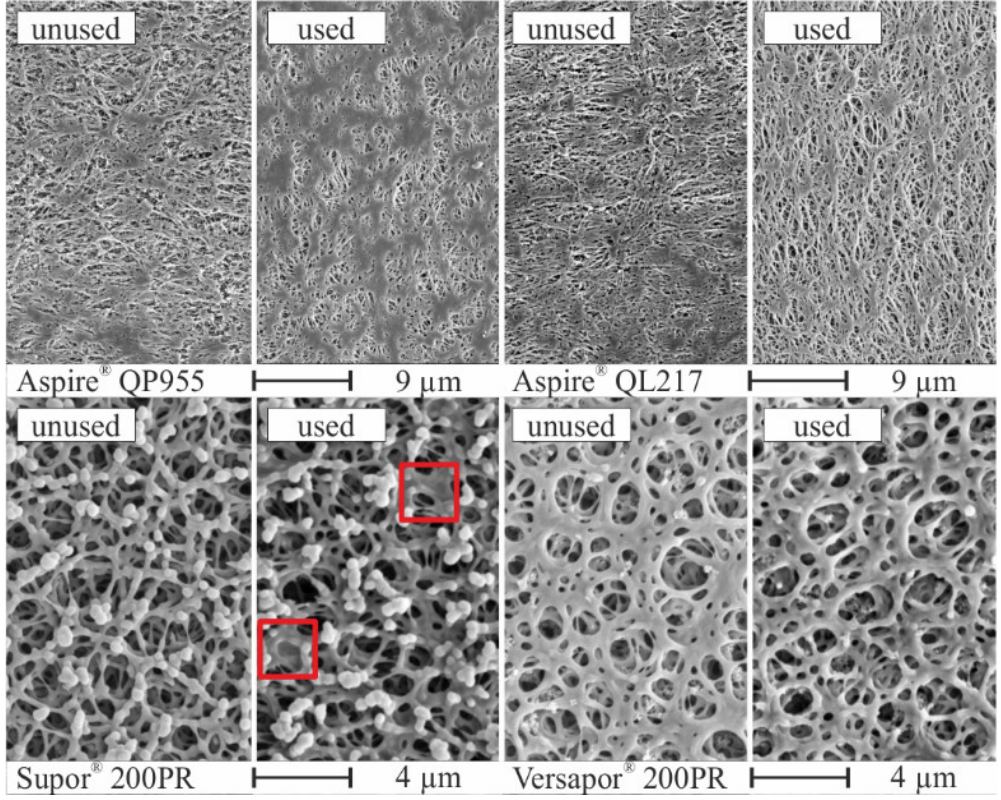
Figure 11. Images of the membrane surface by scanning electron microscopy after usage as separation layer for all experimental investigations.